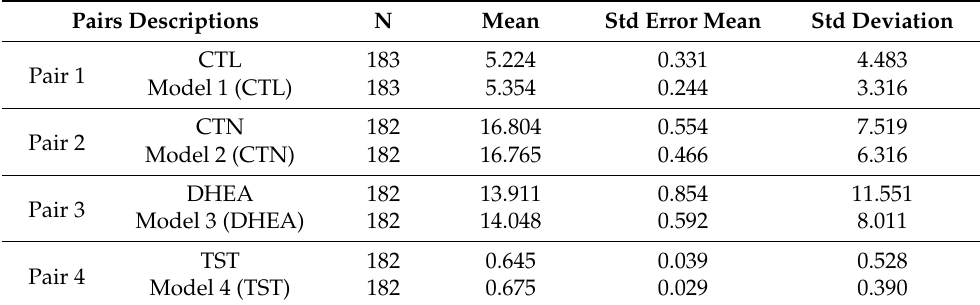
Table A1. Paired samples statistics for measured and predicted levels of stress-related hormones.